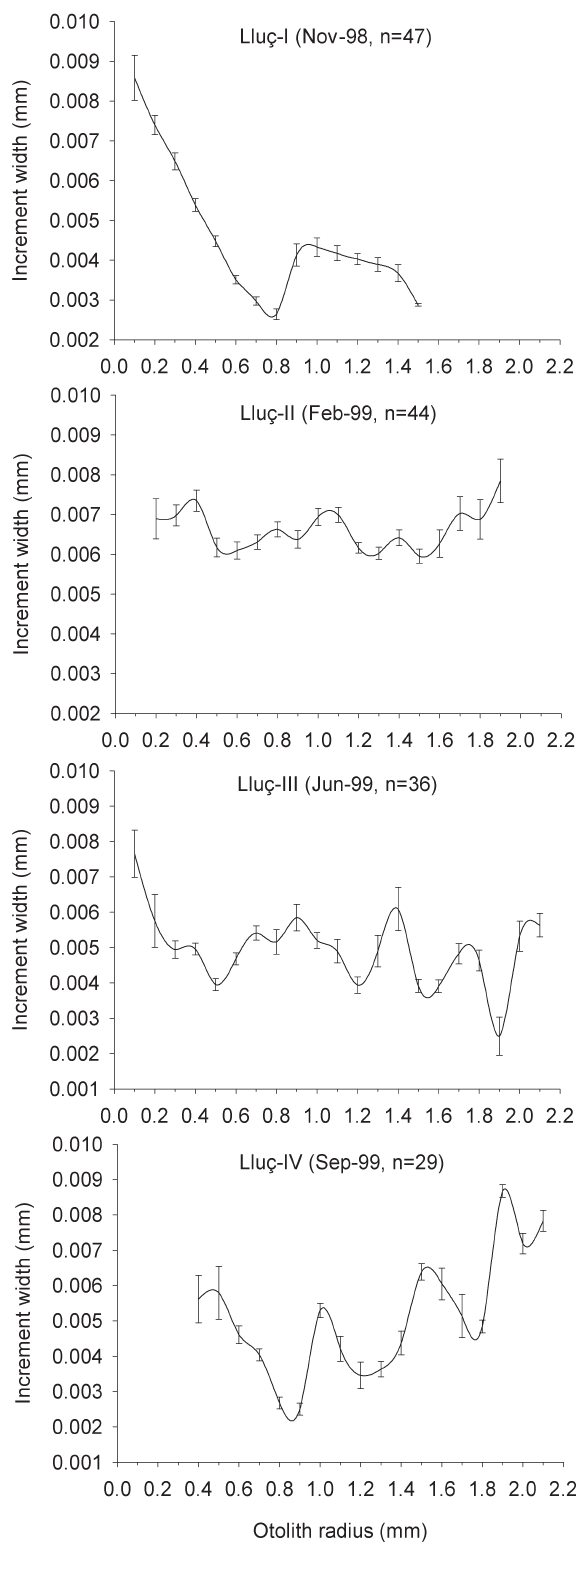
F IG . 10. – Evolution of the mean increment width (±standard error) for the 60 outer increments related to the otolith radius for each cruise. The radius 0.0 corresponds to the otolith core (n= number of otoliths